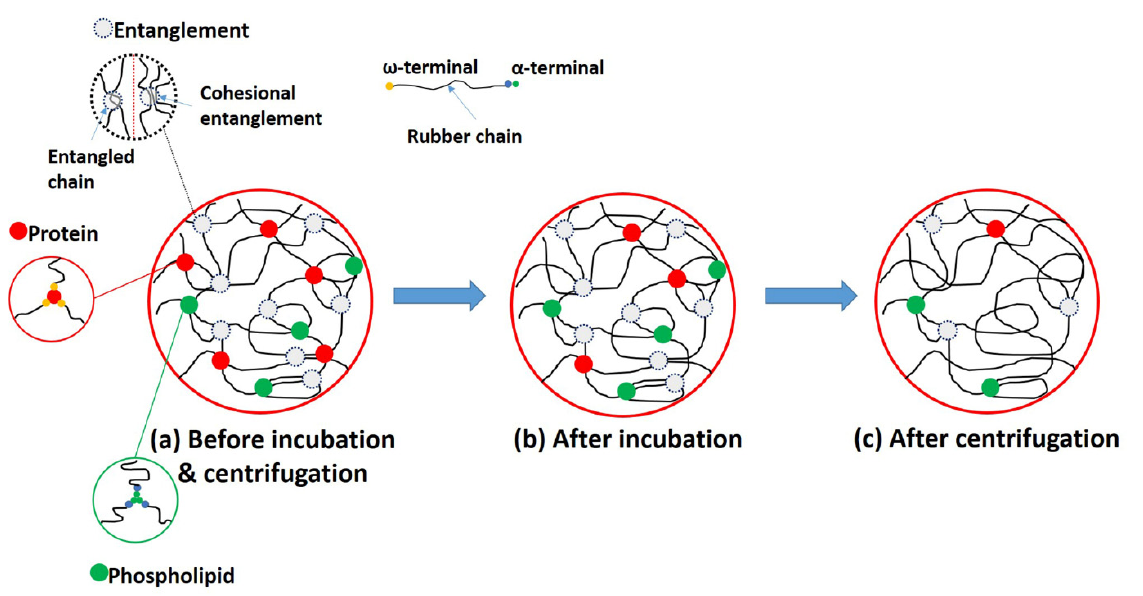
Figure 10. Proposed model for latex before and after the deproteinized process.